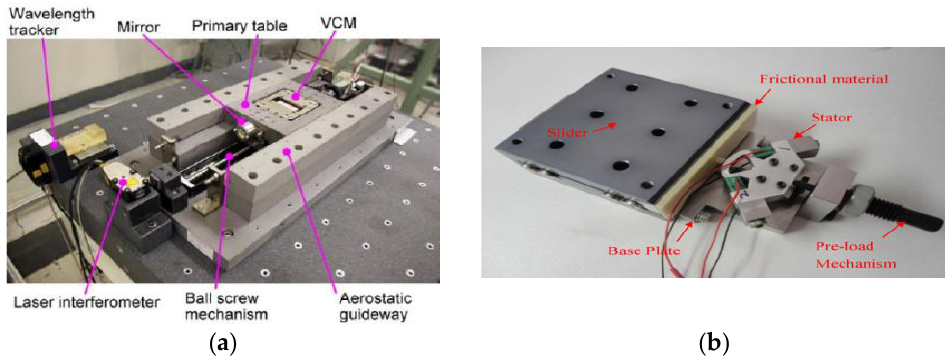
Figure 7. ( a ) Macro – micro-positioning system [76]; ( b ) prototype of a linear piezoelectric motor. Reprinted with permission from ref. [86] Copyright 2016 Elsevier.